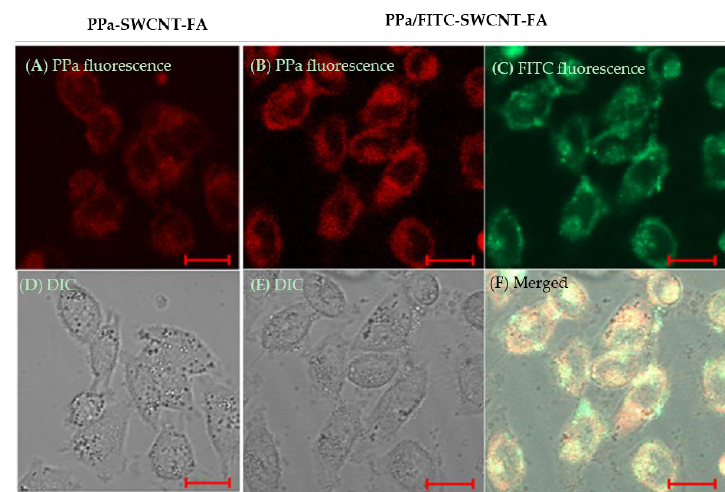
Figure 5. Optical microscopy images of Hela cells treated with PPa-SWCNT-FA ( A and D ), and PPa/FITC-SWCNT-FA ( B , C, E and F ); Confocal fluorescence images ( A, B, C and F ) and transmittance images ( D and E ). FITC excited at 488 nm. PPa excited at 633 nm. Scale bar, 20 μm.